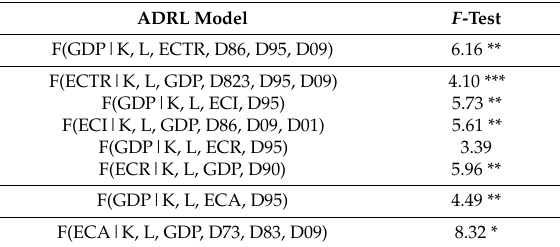
Table 5. ADRL co-integration analysis at the disaggregated